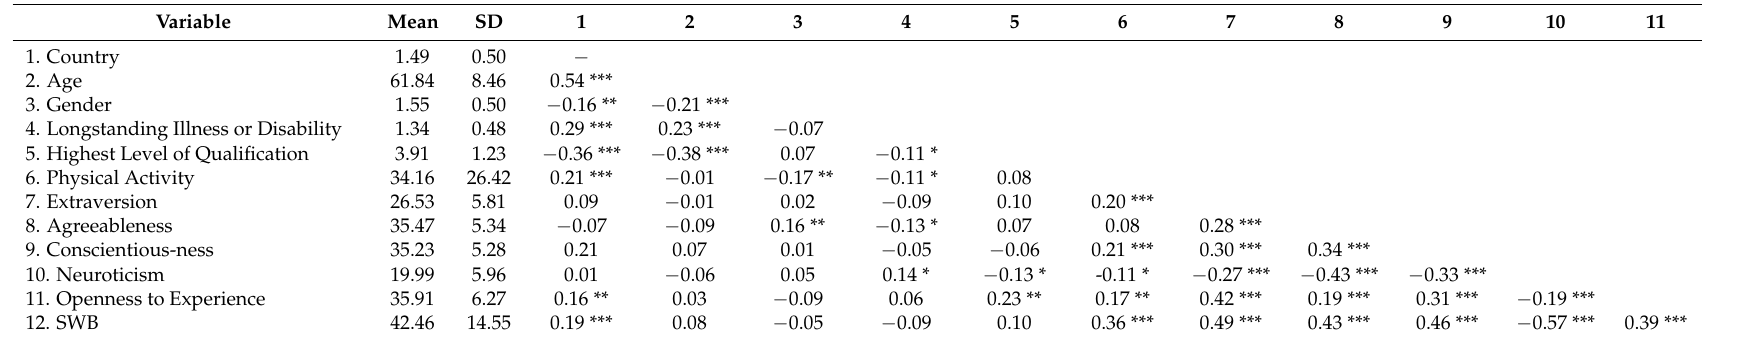
Table 3. Mean, SD, and Pearson inter-correlations for study